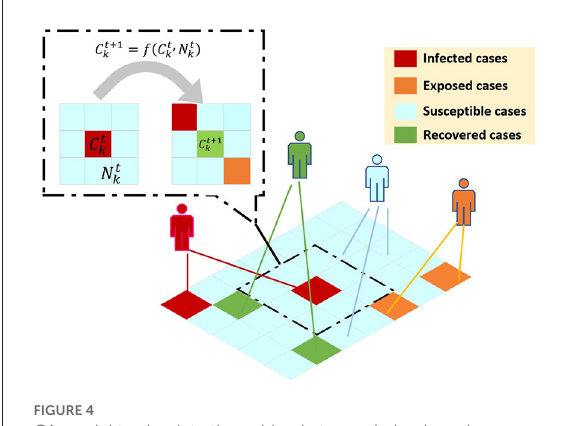
FIGURE4 CA model to simulate the epidemic transmission based on virtual geographic grids. C t + 1 k represents the cellular state of cell k at time t + 1, C t k represents the cellular state of cell N t k represents the neighborhood cellular state of cell and f represents the transformation function of cell from the state at time t to the state at time t +